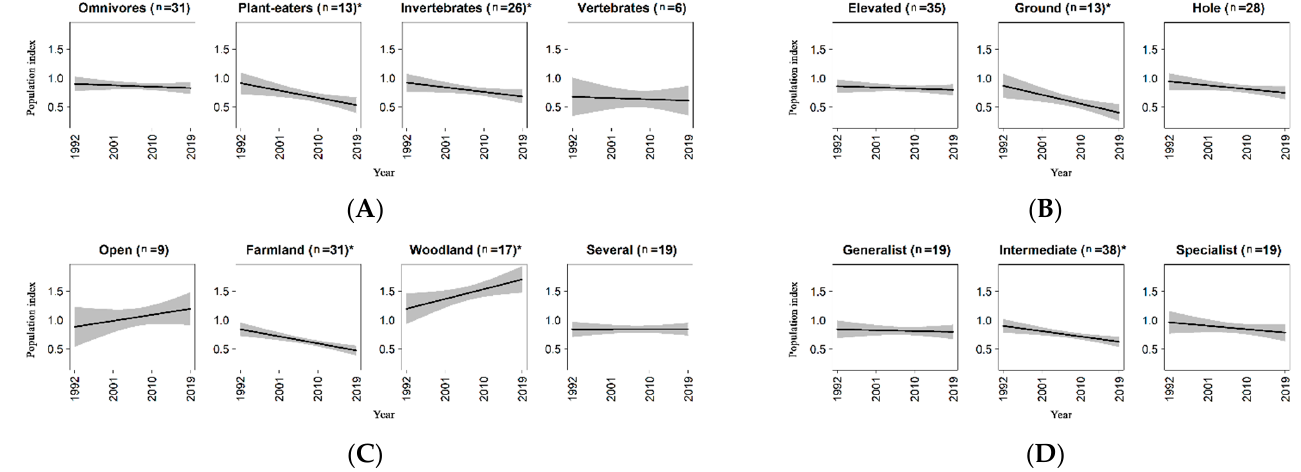
Figure 3. Population trends for bird species grouped according to ecological traits. ( A ) Diet; ( B ) nest type; ( C ) landscape type; ( D ) overall specialization index. Y-axis represents the relative abundance of the species (see Section 2.4.2 for details). The number of species in each group is shown in parentheses. The asterisk indicates the significance of the trend in relation to non-zero slope.